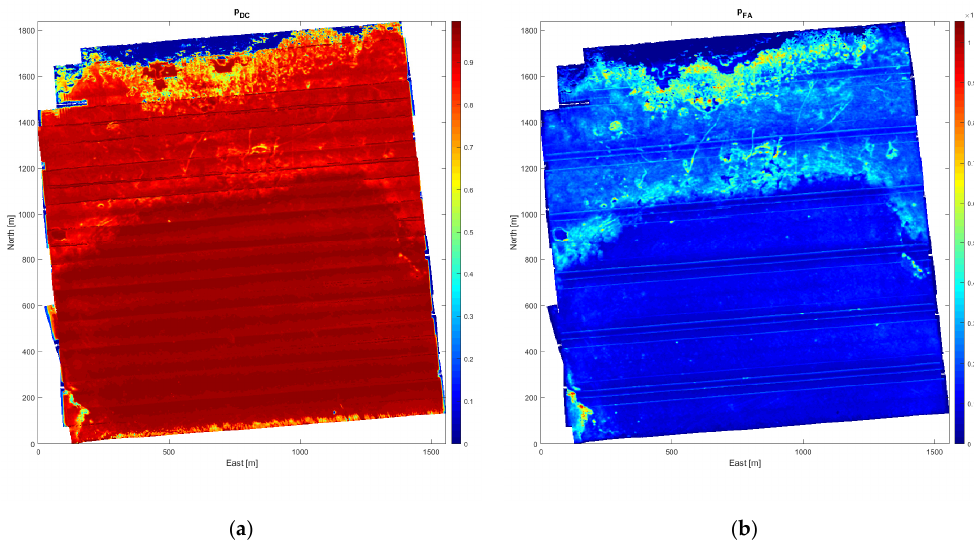
Figure 6. TTS performance parameters obtained from processing of the SAS imagery. ( a ) p DC surface; ( b ) p FA surface.